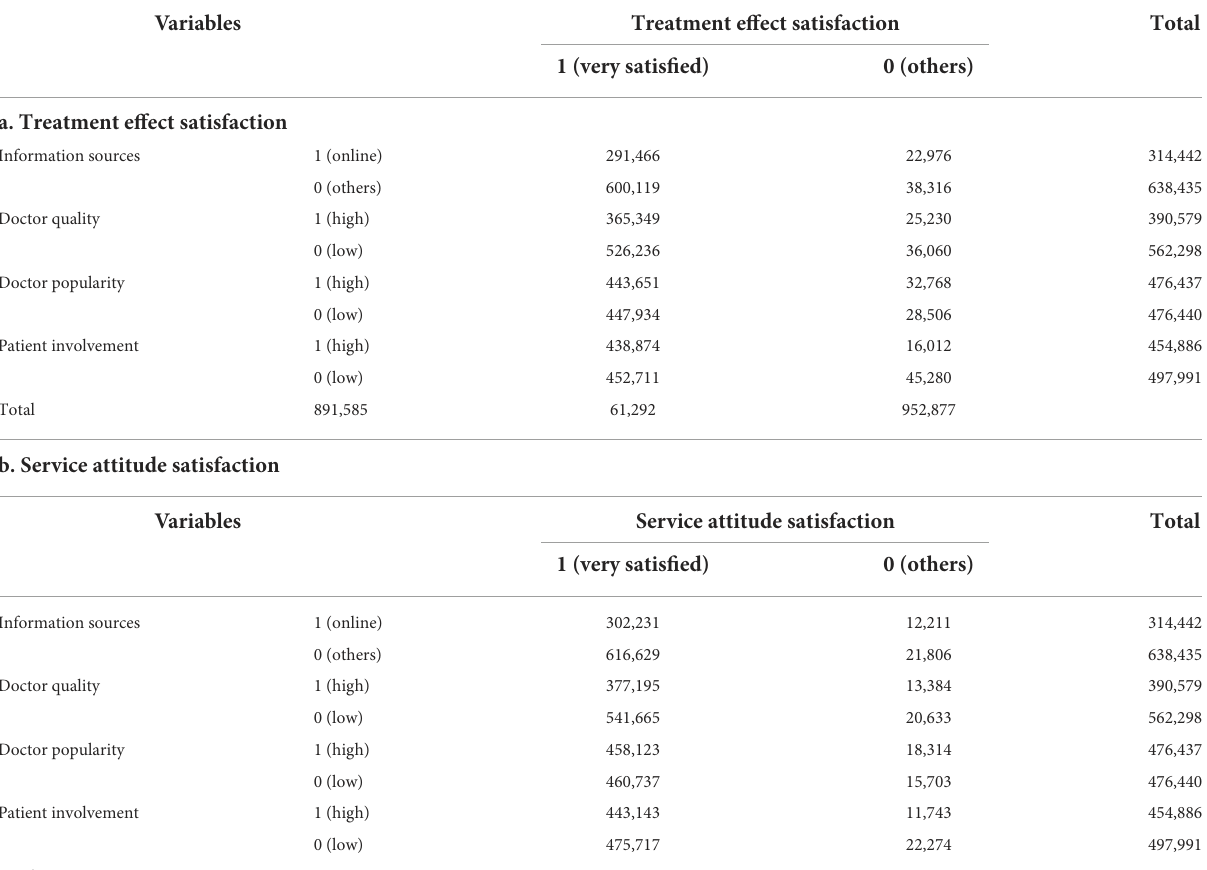
TABLE 3 Summary of the odds ratio of patient satisfaction for main